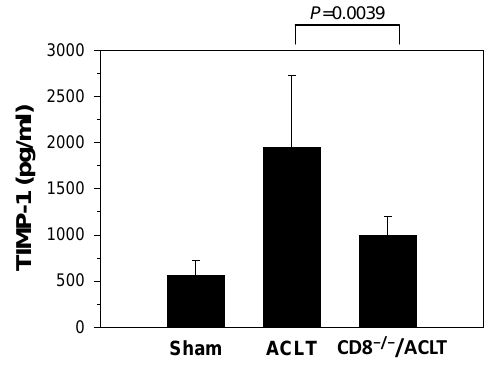
Figure 3. The levels of TIMP-1 in joints after OA induction. TIMP-1 expression was significantly higher in ACLT-group mice than in Sham- and CD8 −/− /ACLT-group mice (determined using ELISA). Values are means ± 95% confidence intervals ( n = 7 per group). Results are representative of three independent